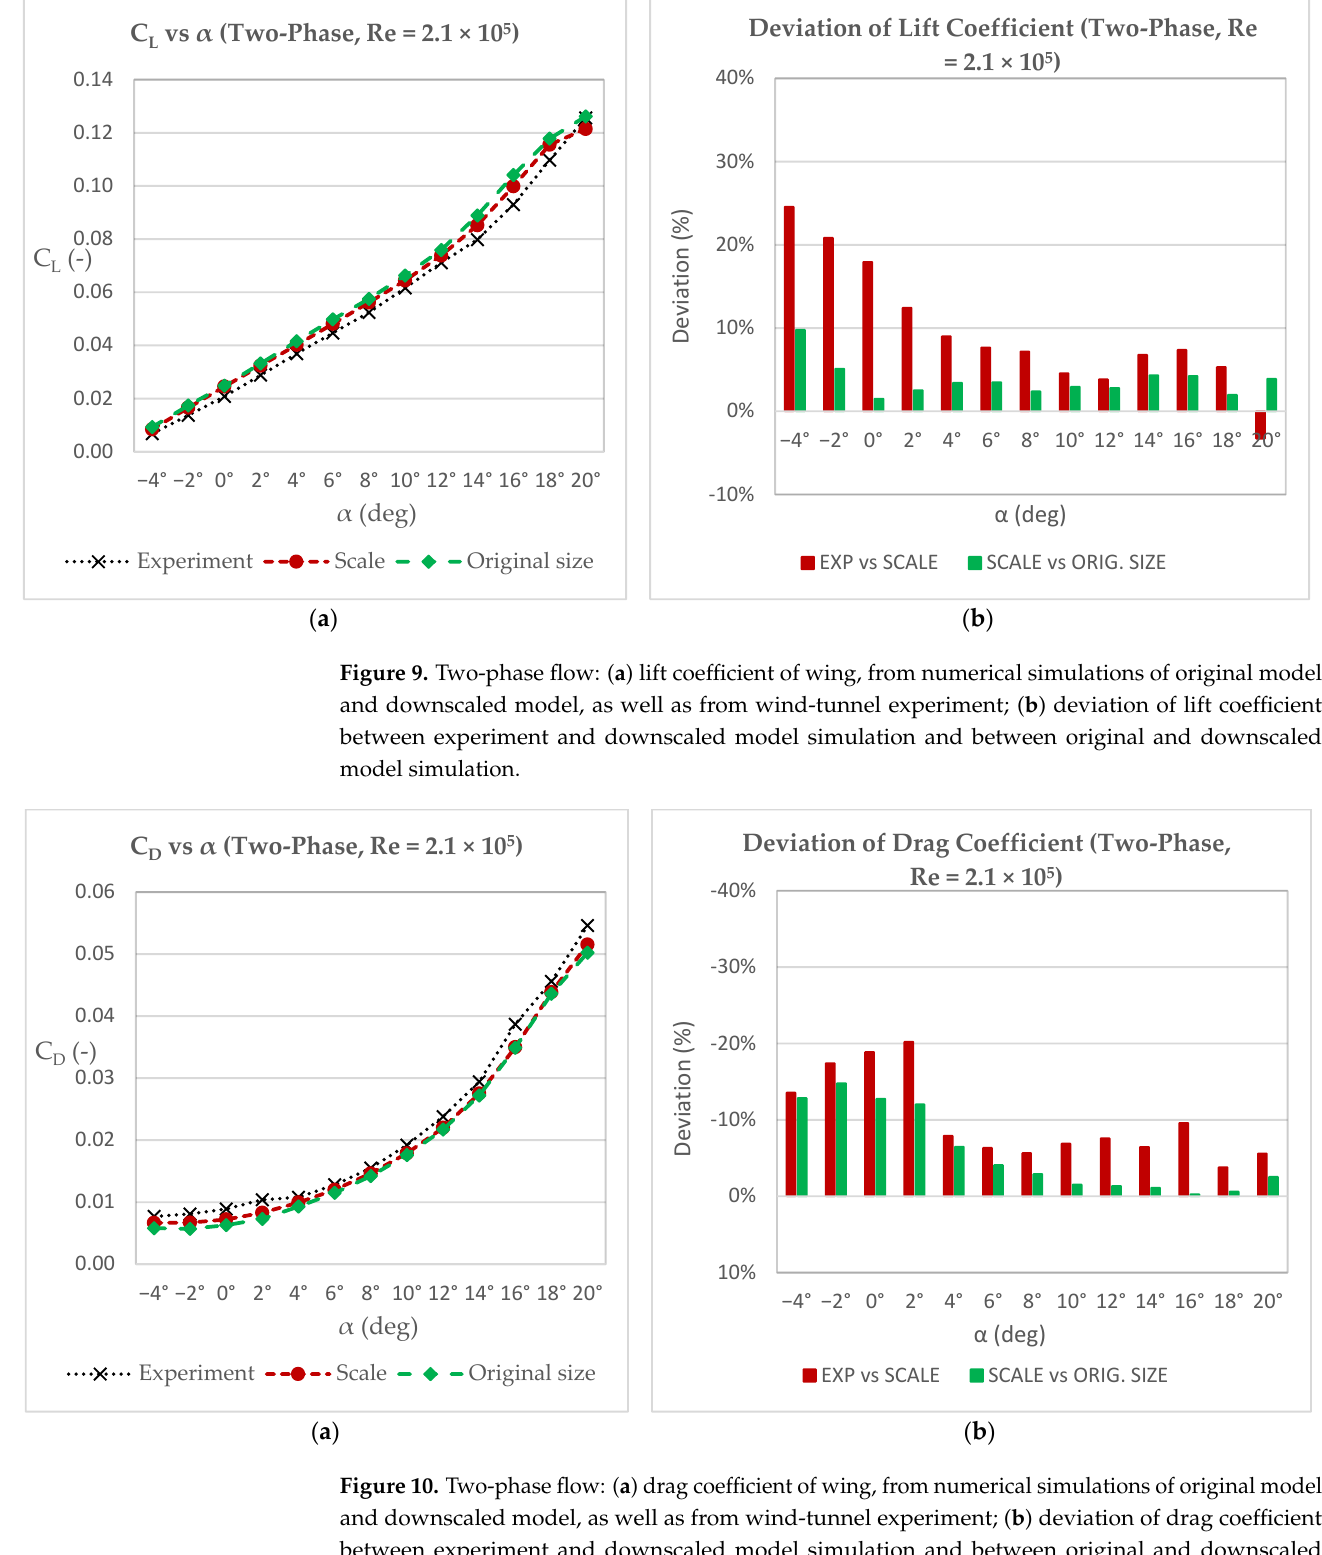
Figure 10. Two-phase flow: ( a ) drag coefficient of wing, from numerical simulations of original model and downscaled model, as well as from wind-tunnel experiment; ( b ) deviation of drag coefficient between experiment and downscaled model simulation and between original and downscaled model simulation.